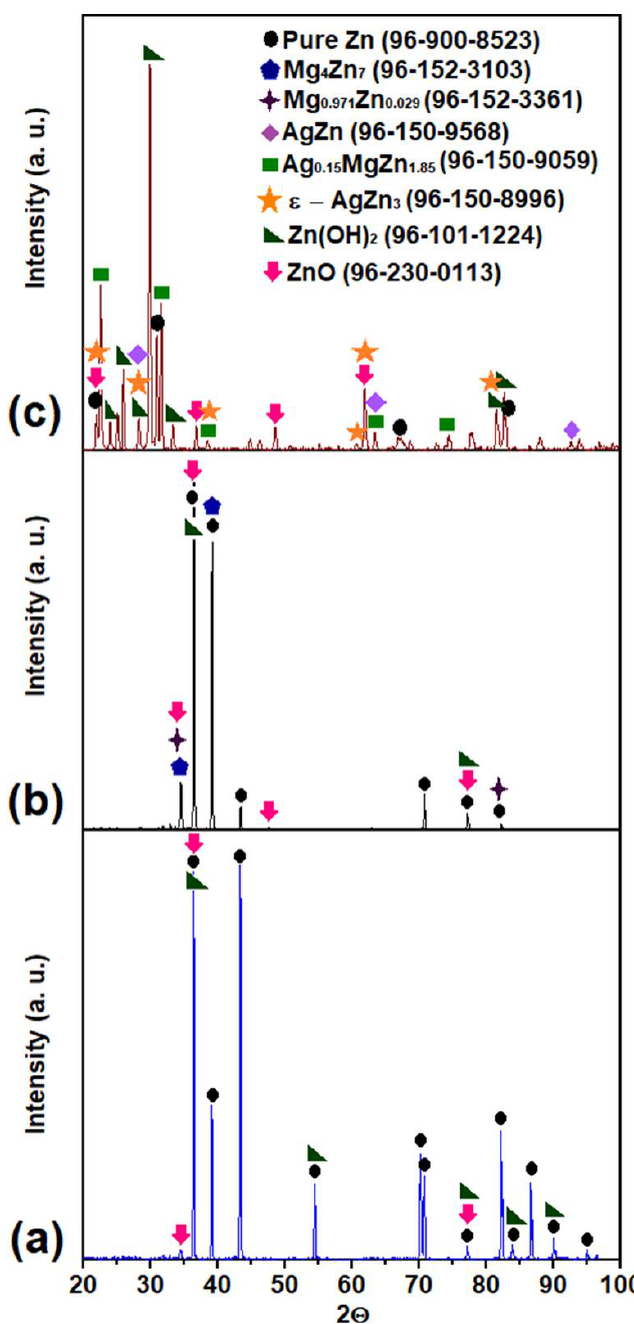
Figure 14. XRD patterns of the as-extruded specimens after potentiodynamic testing in a NaCl solution at 37 °C, pH = 7.4: ( a ) pure Zn, ( b ) Zn-1Mg alloy, and( c ) Zn-12.5Ag-1Mg